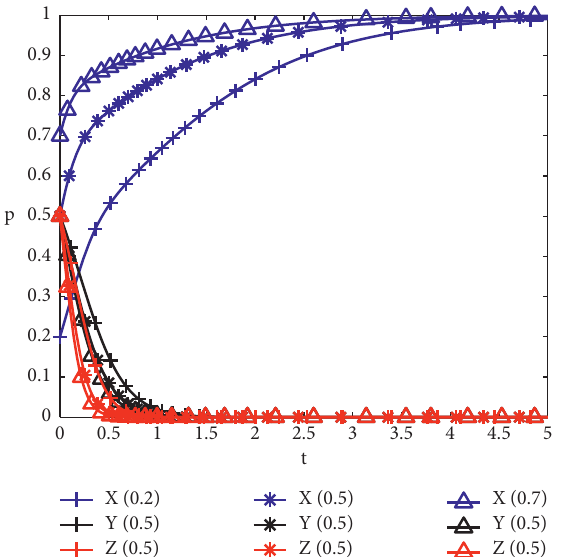
Figure 7: The evolution result of the change of government’s initial strategies.